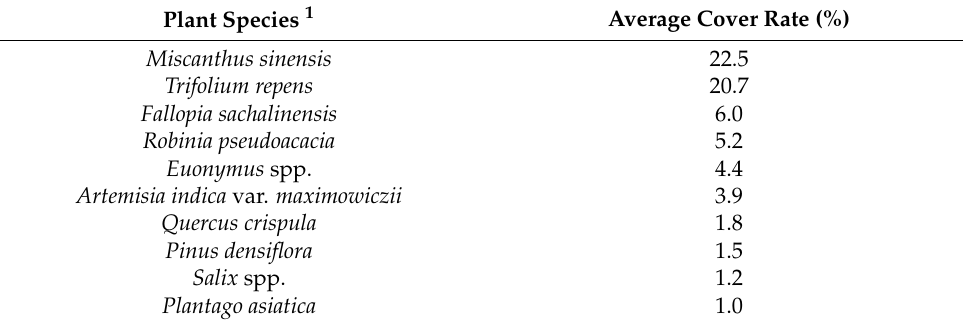
Table 1. Vegetation survey results in the study